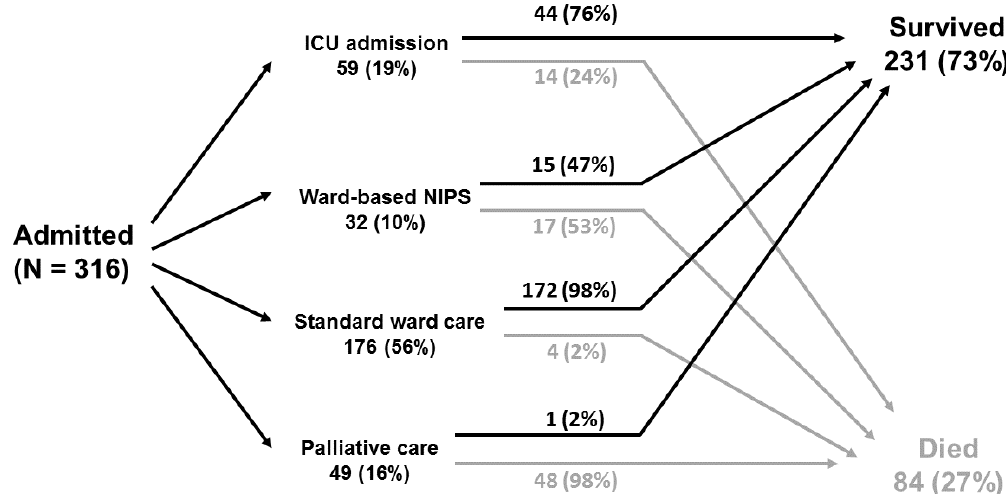
Figure 2. Schematic summarising treatment groups and patient outcomes. Note one patient in ICU group remained hospitalised at time of analysis. ICU: intensive care unit; NIPS: non-invasive pressure support.